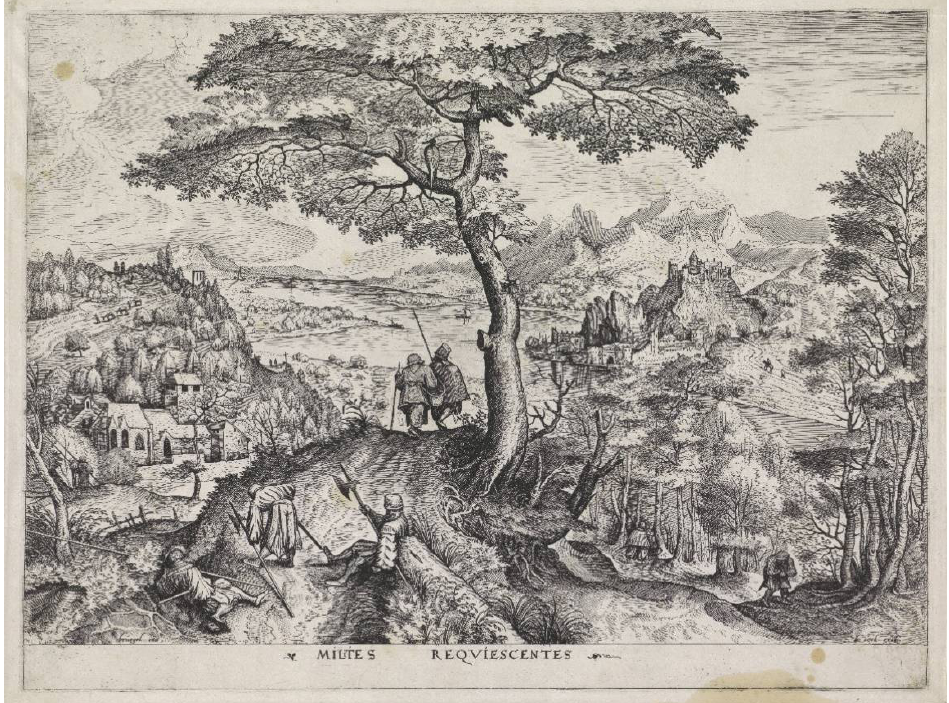
Figure 5. Jan or Lucas van Doetechum after Pieter Bruegel I. Milites Requiescentes ( Soldiers at Rest ) from the series Great Landscapes. Antwerp, 1553–1558. Engraving on paper. 32.5 × w 44.2 cm. Artwork in the public domain; image courtesy of the Rijksmuseum, Amsterdam.